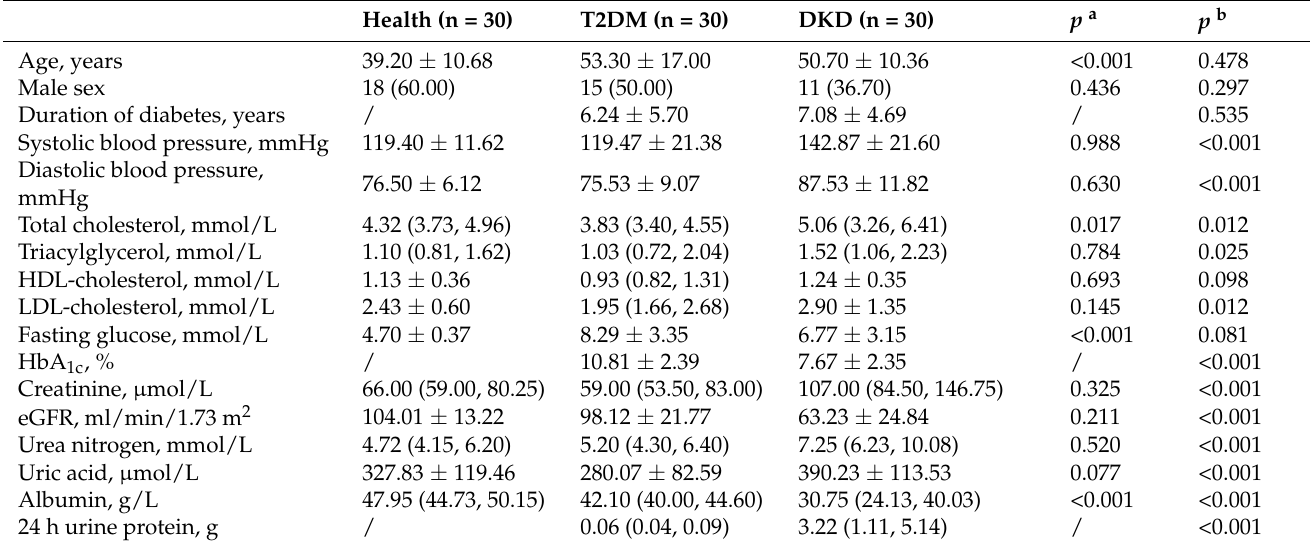
Table 1. Clinical and biochemical parameters in Health, T2DM, and DKD